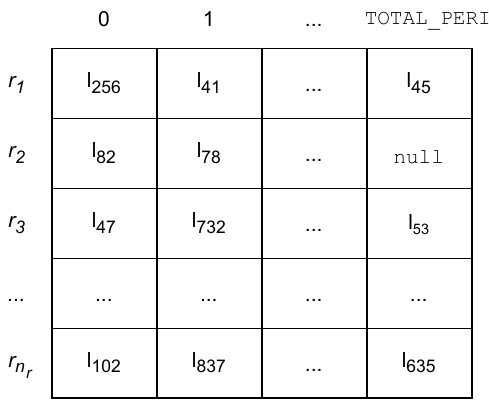
Figure 5. The matrix representing the